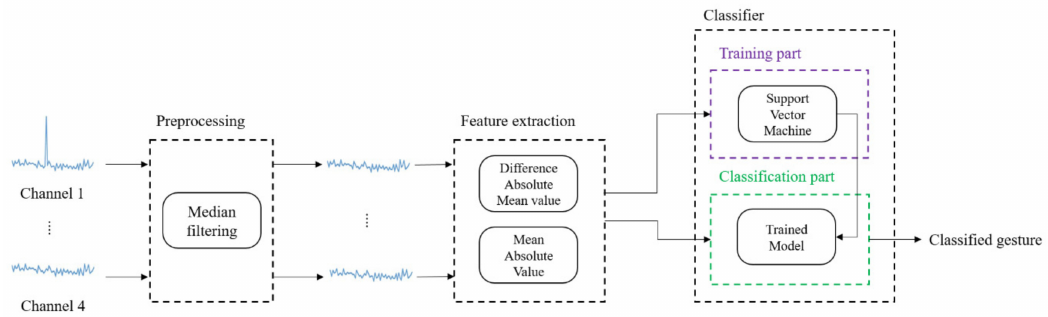
Figure 6. Overview of the process of gesture recognition method using the proposed